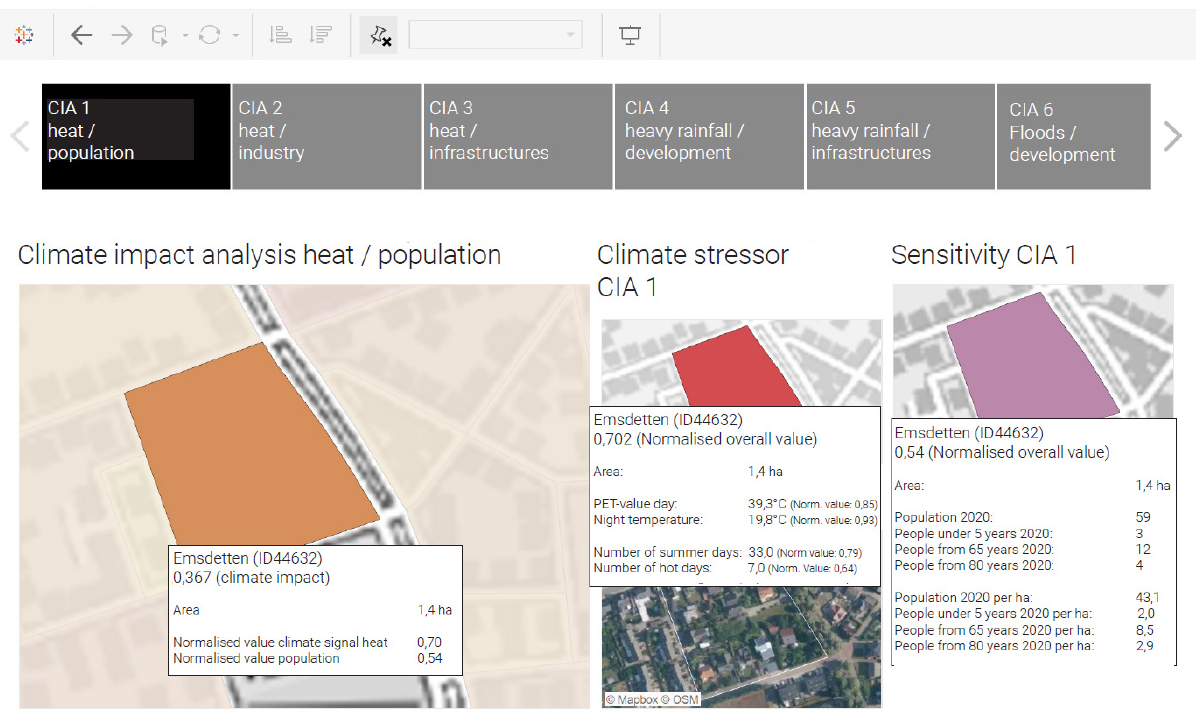
Figure 5. ER regions: Methodology of multi‐criteria analysis. Source: Schmitt and Wright (2021). and socio‐economic changes (in terms of